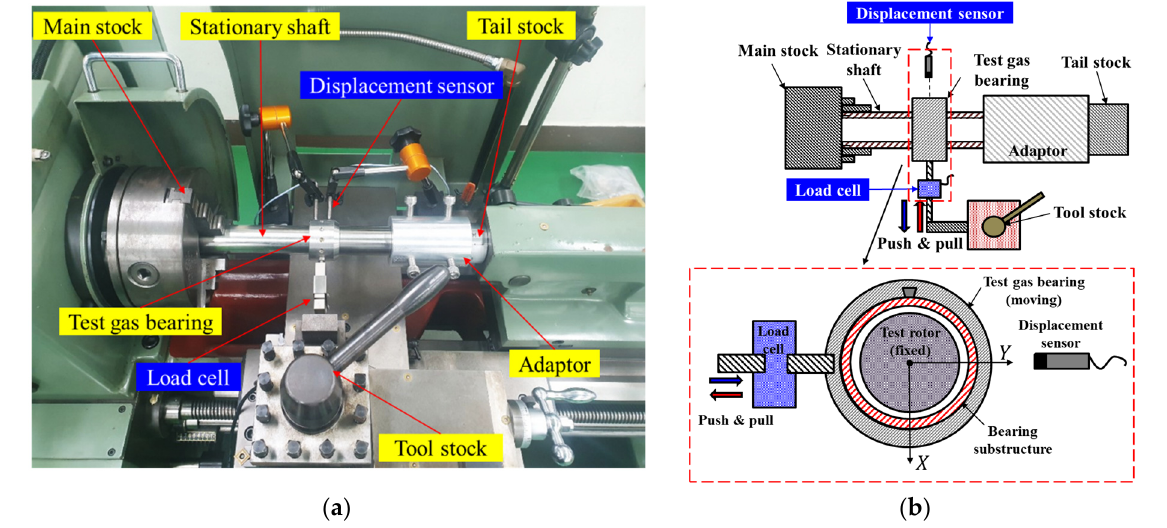
Figure 3. Static load–deflection test setup: ( a ) photograph of test environment, and ( b ) schematic view of the test.